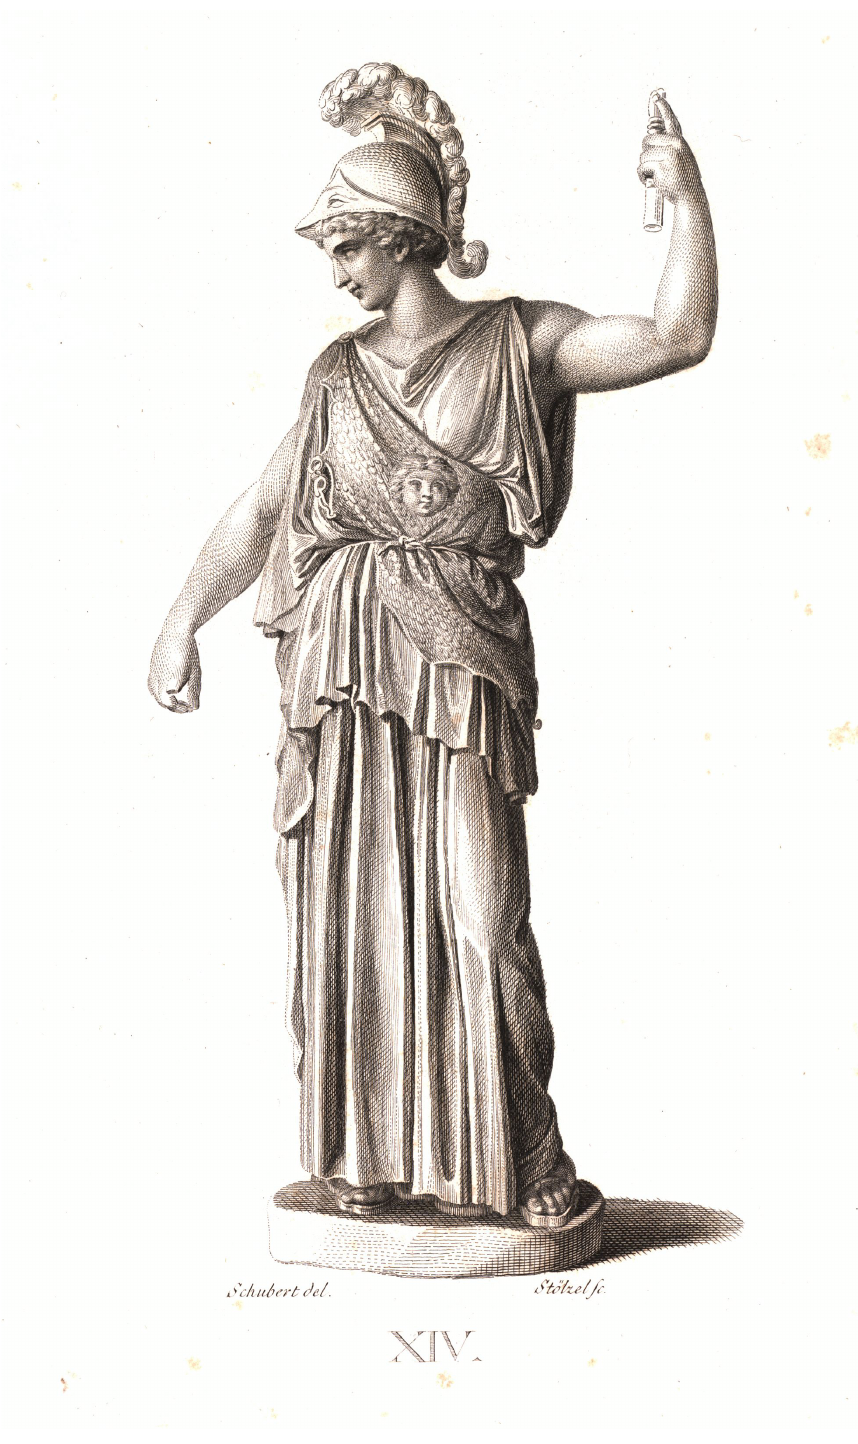
Figure 12 Minerva, in: Becker, Augusteum, Plate XIV (photo: